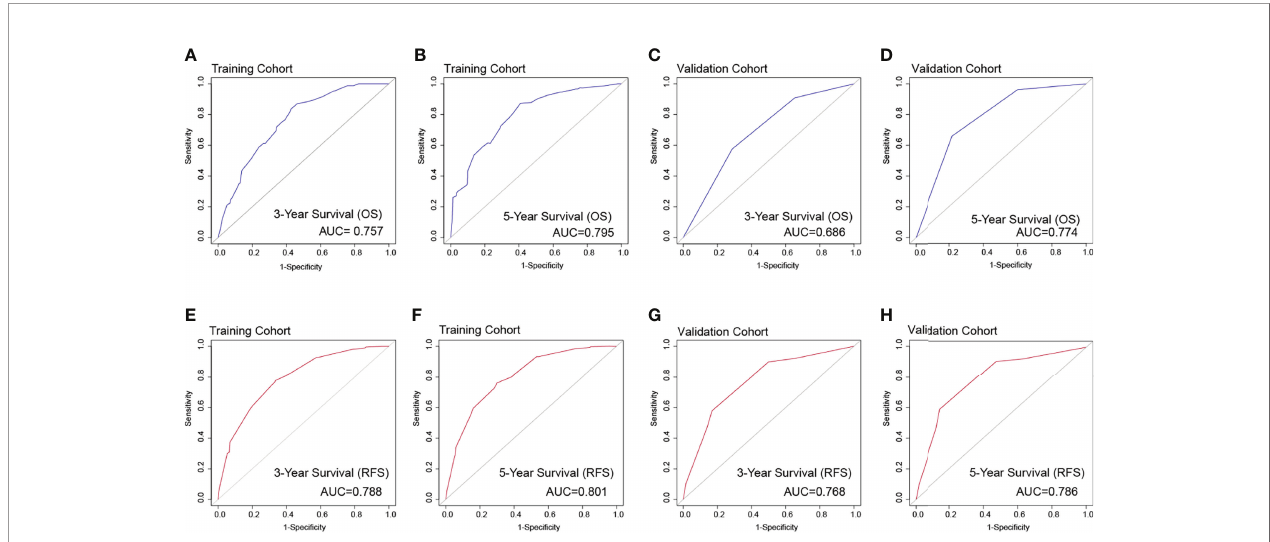
FIGURE 2 | The overall survival ROC curves for 3 years (A) and 5 years (B) , respectively, validated by the model establishment training cohort; ROC curves for 3 years (C) and 5 years (D) , respectively, validated by the validation group. The recurrence-free survival ROC curves in the training cohort [ (E) 3 years; (F) 5 years] and the validation cohort [ (G) 3 years; (H) 5 years].